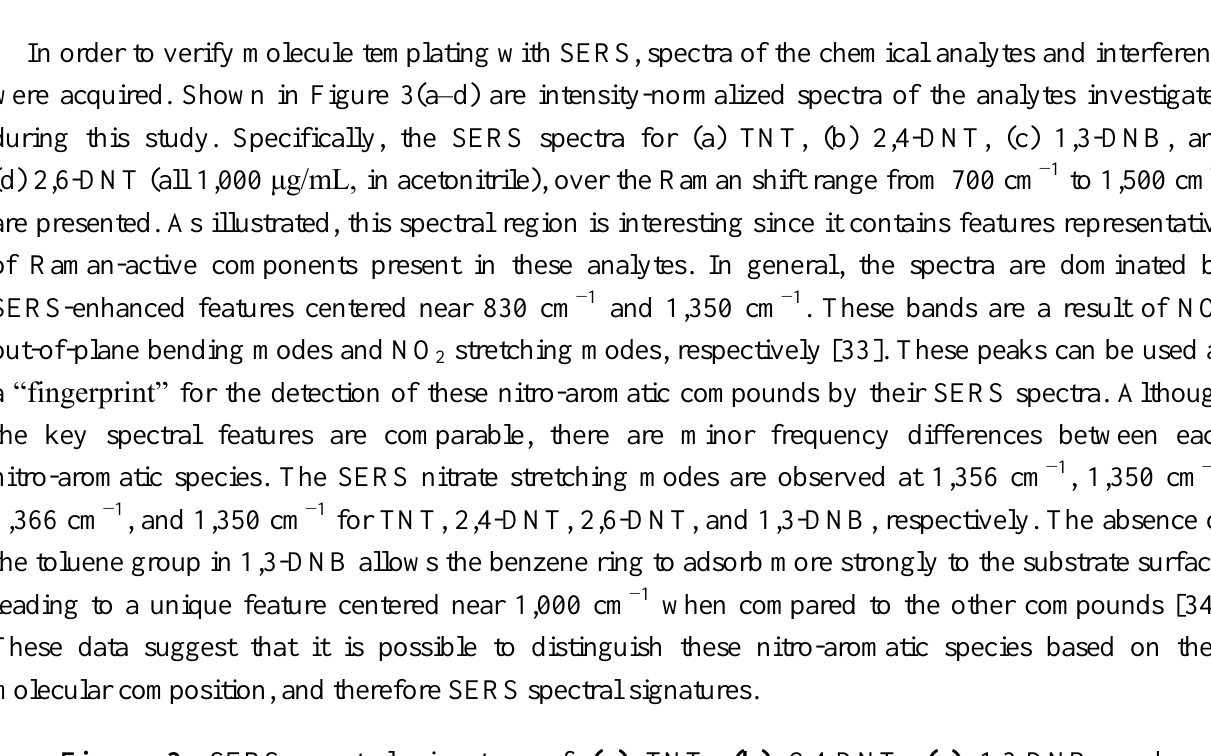
Figure 3. SERS spectral signature of (a) TNT, (b) 2,4-DNT, (c) 1,3-DNB, and (d) 2,6-DNT on Klarite ® . Spectra are offset for clarity. The vertical dashed lines are aligned with the characteristic NO out-of-plane bending and stretching modes of 2